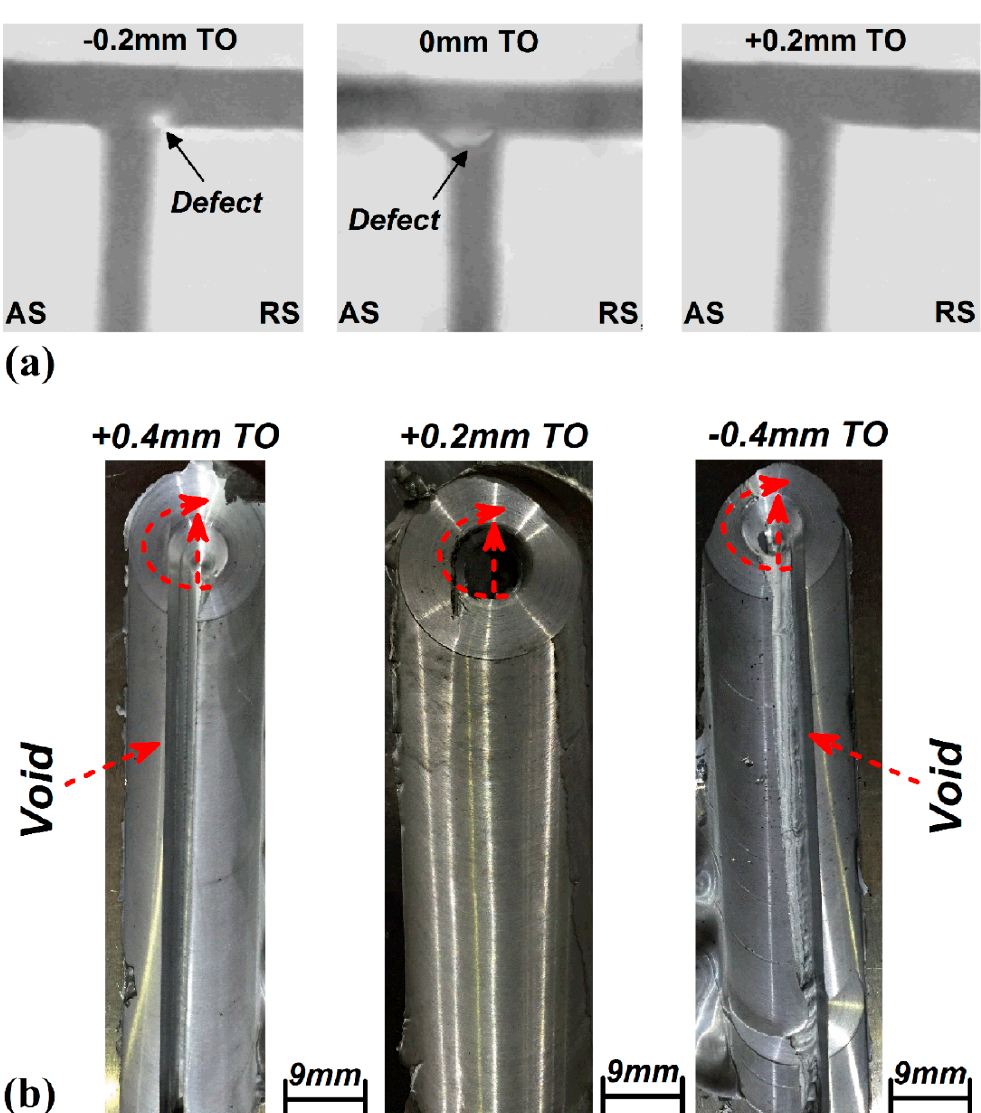
Figure 6. ( a ) Radiography image from welded samples. ( b ) Surface materials flow of various samples.